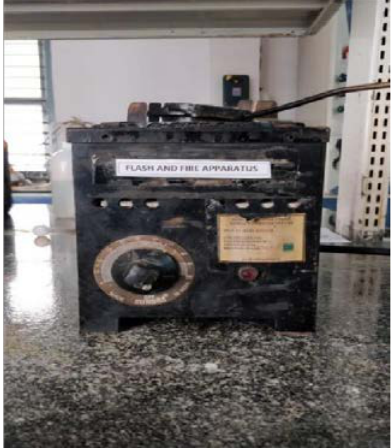
Figure 1: Experimental setup for density test as per IS:1448 (Part 16) standards.